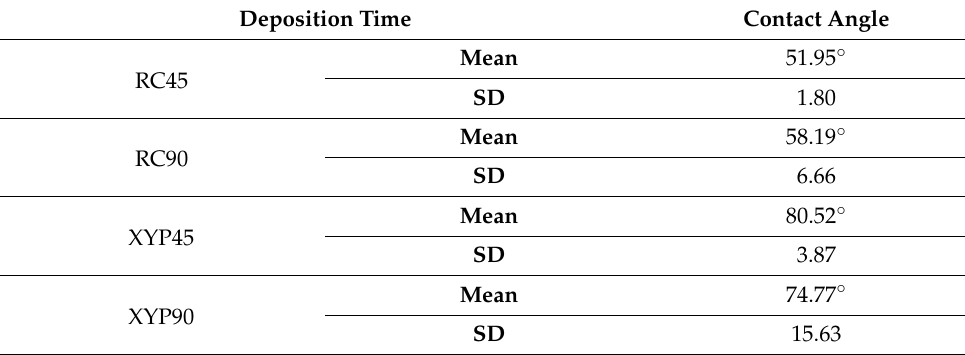
Table 4. Contact angles according to collector type.